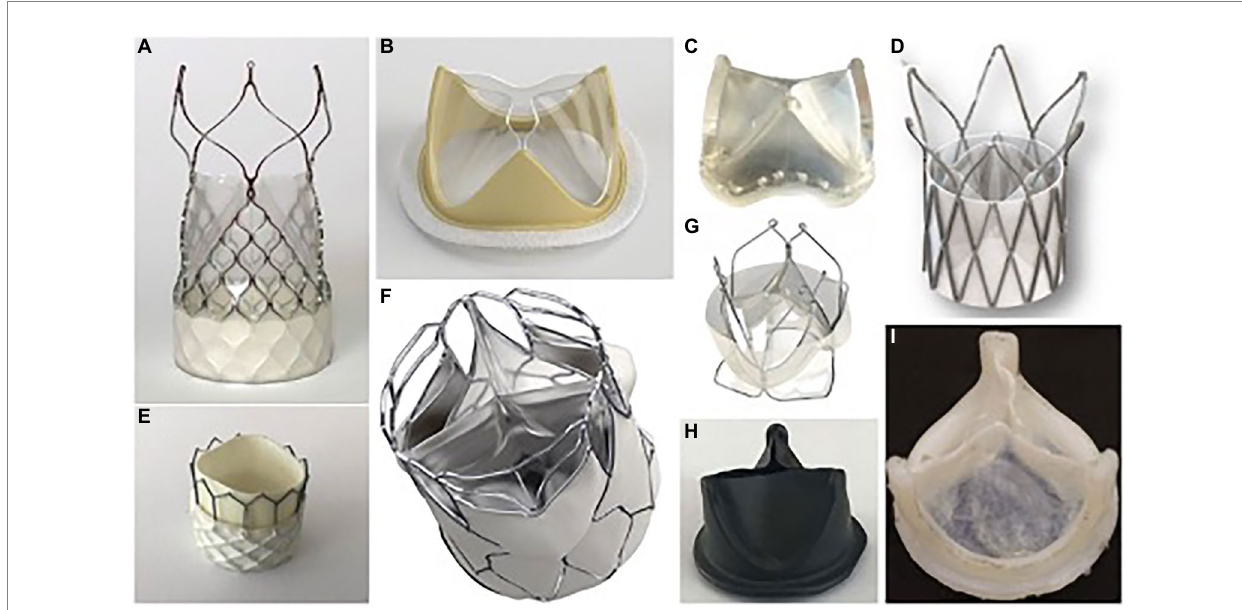
FIGURE 1 Selected polymeric heart prostheses. (A) Foldax Tria TAVR; (B) Foldax Tria SAVR A-M; (C) PoliValve; (D) Polynova TAVR; (E) Inflow TAVR; (F) SAT TAVR; (G) Triskele TAVR; (H) Hastalex; (I)